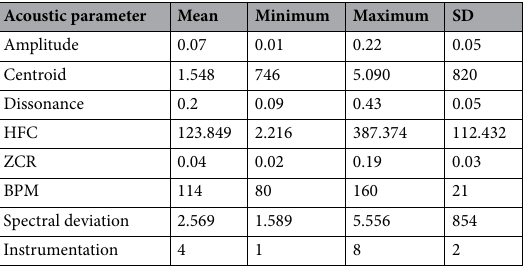
Table 1. Summary statistics of acoustic parameters of the 39 musical pieces. HFC high frequency content (kHz), ZCR zero crossings rate, BPM beats per minute, SD standard deviation.